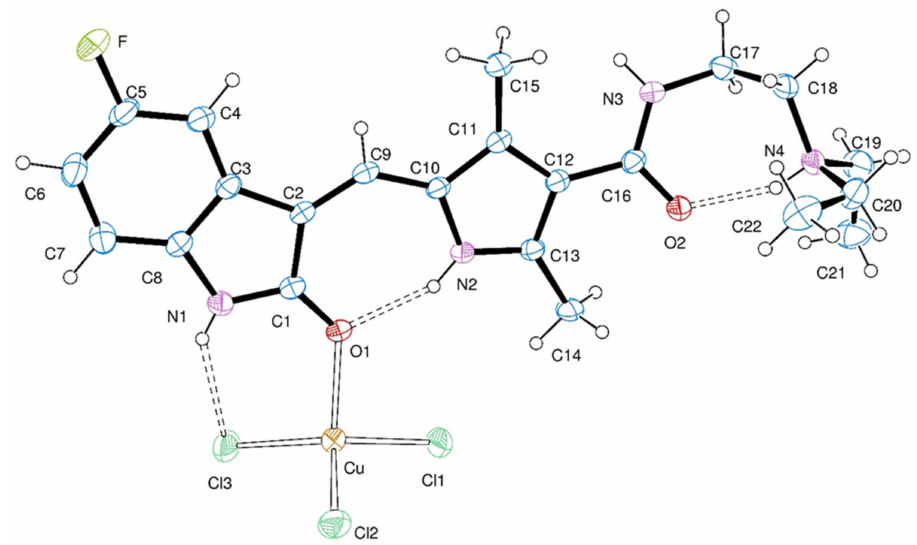
Figure 2. View of trichlorosunitinibcopper(II) (CuSun) molecule, showing the labeling of the non-H atoms and their displacement ellipsoids at the 30% probability level. Copper-ligand bonds are indicated by open lines and intra-molecular H-bonds by dashed lines. Table 1. Crystal data and structure refinement results for trichlorosunitinibcopper(II)